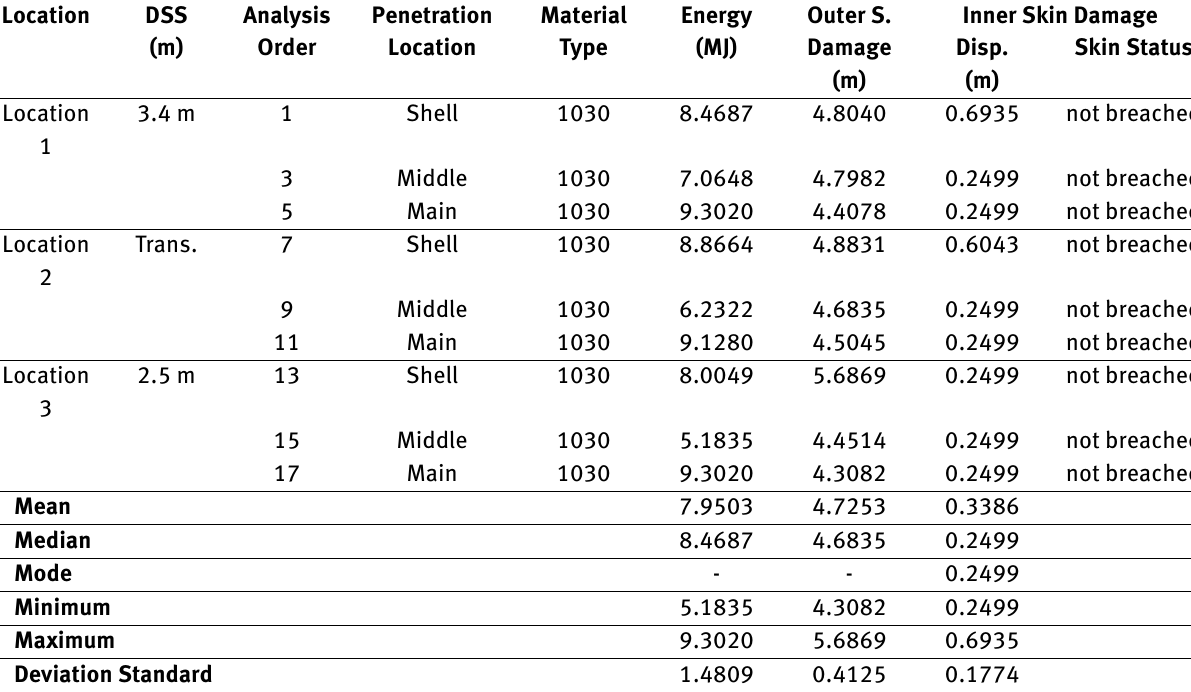
Table B.1: Statistical analysis on destroyed material